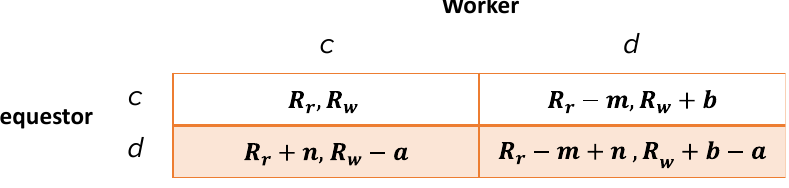
Figure 1. Payoffs of the requestor and the worker at each